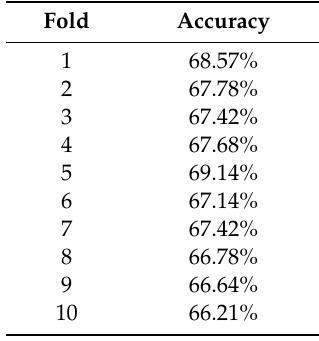
Table 6. Accuracy of 10 folds for C = 75, gamma = 0.0001.